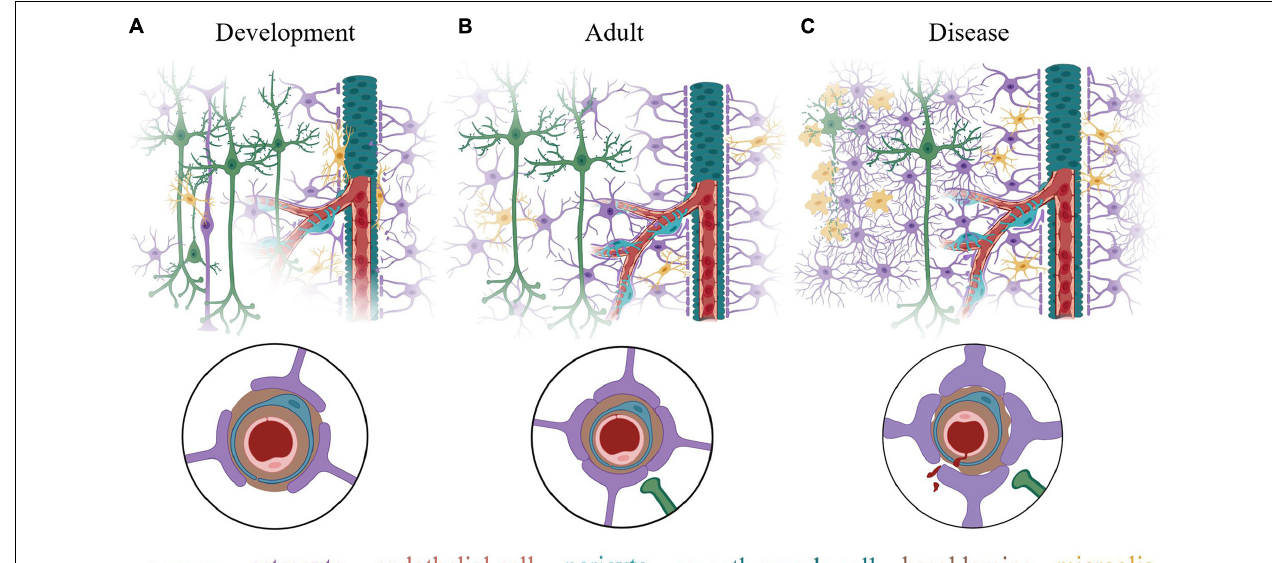
FIGURE 2 | Schematic illustration of the neurovascular unit (NVU) at various life stages. (A) During early post-natal development, all the component cells of the NVU are present but the NVU is not yet mature. This stage is characterized by continuing vasculogenesis and astrogliogenesis and an incomplete coverage of the vasculature by astrocyte endfeet. Neuron density and synapse number is high, while synaptic pruning by microglia to tune the neuronal circuits is continuing. Many microglia are present directly on the vessels, which they use as as migration routes while also guiding angiogenesis. Although cerebral vessels grow and develop with an intact barrier function, it is incomplete without full coverage by astrocyte endfeet, which are necessary for blood-brain barrier maintenance. (B) In the adult ( > at least P21), this system has matured with distinct tiling of astrocytes within the neural tissue and complete endfeet coverage of the cerebral vasculature. An estimated 99.7% of vasculature is covered by astrocyte endfeet in adults, with some spots in contact with microglia. Neuronal density is reduced compared to early development and synaptic pruning is complete. (C) In the context of neurological diseases or injuries, degenerating neurons are physically separated from healthy neuronal tissue by an astrocyte glial scar, composed of overlapping processes of reactive astrocytes that proliferate and lose their territorial properties. Microglia are activated, taking on a phagocytic phenotype at the site of tissue damage. Astrocyte endfeet appear thicken due to an increase in GFAP and vimentin expression and may retract from the basal lamina, which diminishes blood-brain barrier integrity and may interfere with neurovascular coupling and paravascular flow. Insets in circles show a cross section of a capillary in each condition. Created with